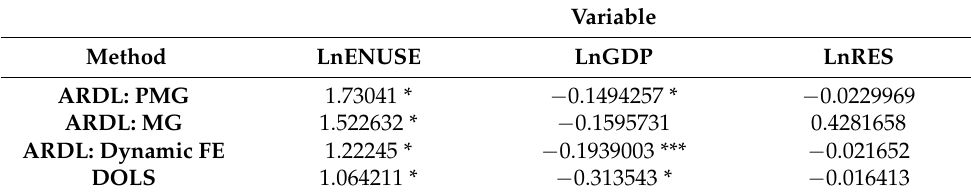
Table 6. Long run